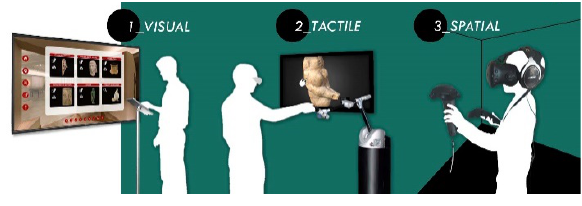
Figure 4. Interactive and technological solutions for learning by interaction in the National Archaeological Museum of Marche.